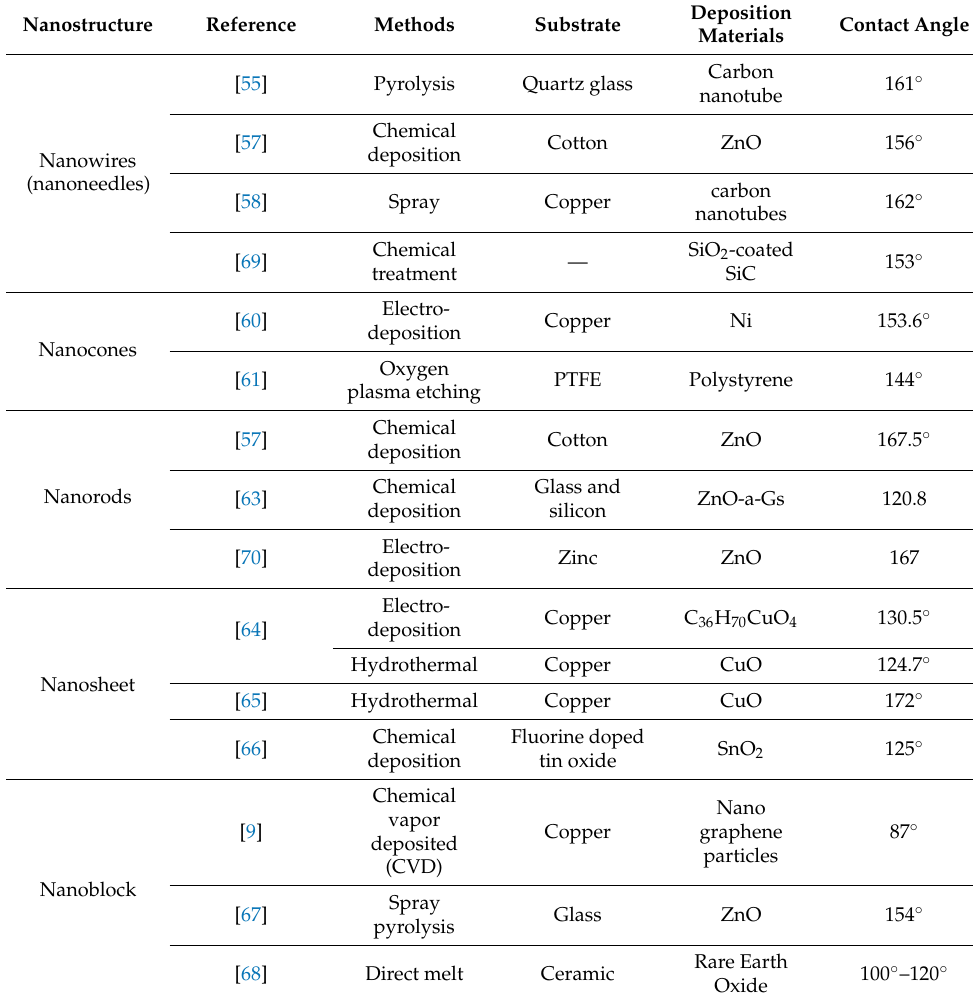
Table 2. Typical micro-nano